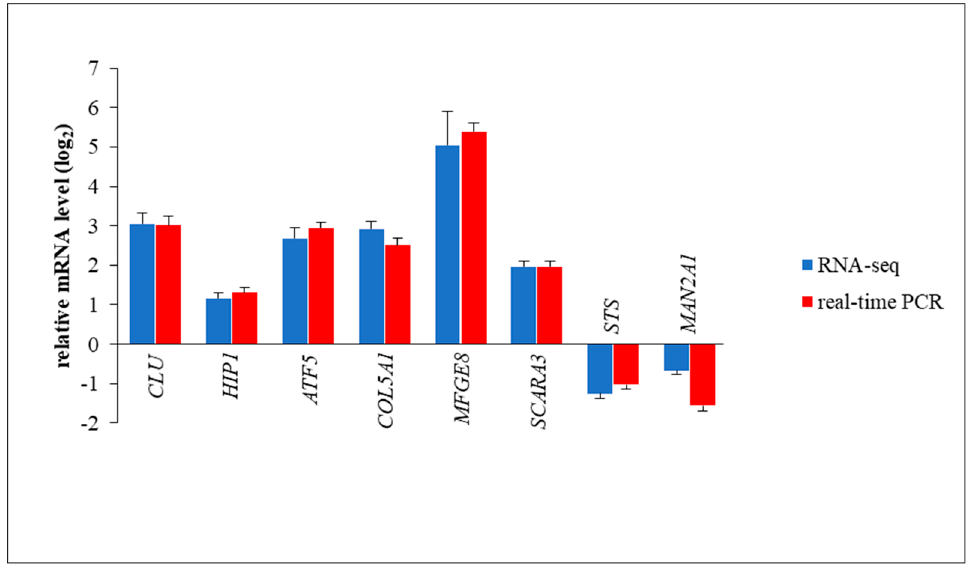
Figure 5. Comparison of results of RNA-seq (blue columns) and RT-qPCR (red columns) for selected genes in various MPS types relative to wild-type HDFa cells. Results for HDFa are normalized as a horizontal line (value 0), and values for particular MPS types reflect this value, with changes in transcript level indicated as log 2 fold change (FC). Results are presented as mean values from four biological experiments, with error bars indicating SD. In all cases, the differences between MPS cells and HDFa cells were statistically significant ( p < 0.05 in one-way ANOVA). Particular genes were tested in different MPS types, as follows: CLU in MPS II, HIP1 in MPS IIIB, ATF5 in MPS IX, COL5A1 in MPS IIIC, MFGE8 in MPS IIIA, SCARA3 in MPS VI, STS in MPS IIID, and MAN2A in MPS VII.